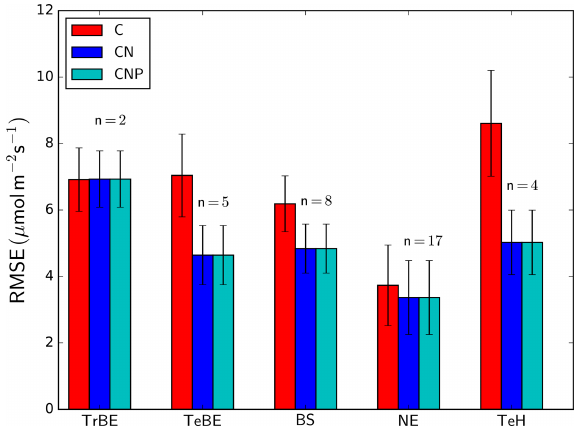
Figure 5. Root mean square error (RMSE) for simulated GPP by dominant plant functional type (see Table 1). The number of sites used in the calculation of the PFT-specific RMSE value ( n ) is shown above the bars for each PFT. The error bars denote the standard deviation of the RMSE values of the different sites within each PFT. “C”, “CN”, and “CNP” refer to the model simulations with C, C&N, and C&N&P options